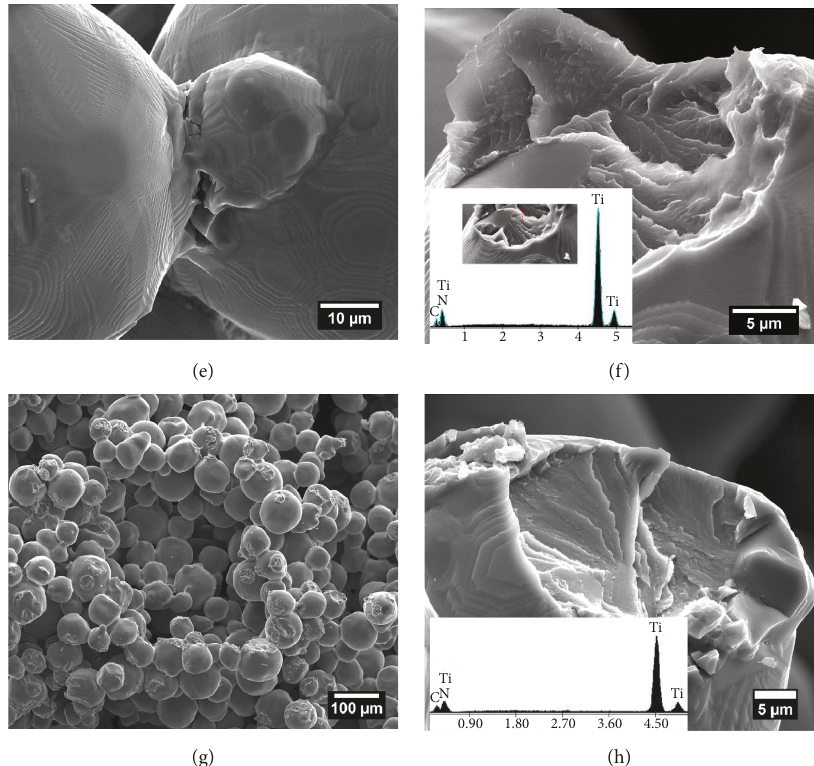
Figure 12: SEM images of Ti foams after compression testing made with (a-b) SP607, (c-d) SP380, (e-f) CU336, and (g-h)